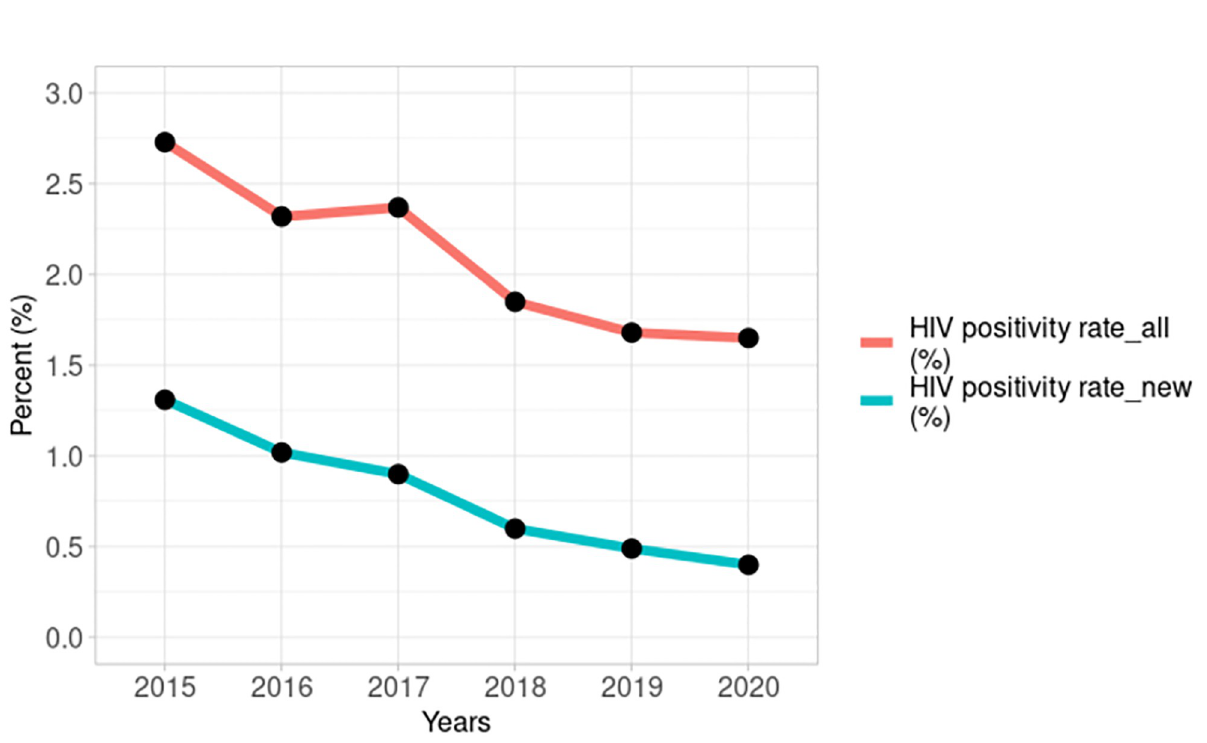
Fig 8. Annual HIV positivity rates among pregnant women considering newly diagnosed HIV positive pregnant women alone and all HIV positive pregnant women from 2015–2020.